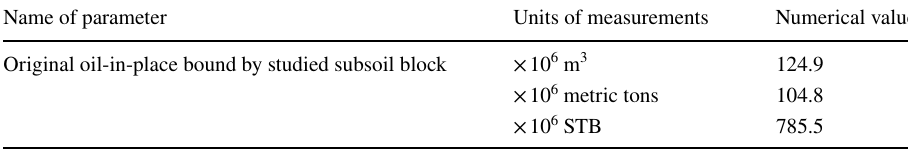
predictions for Blagodarnenskaya